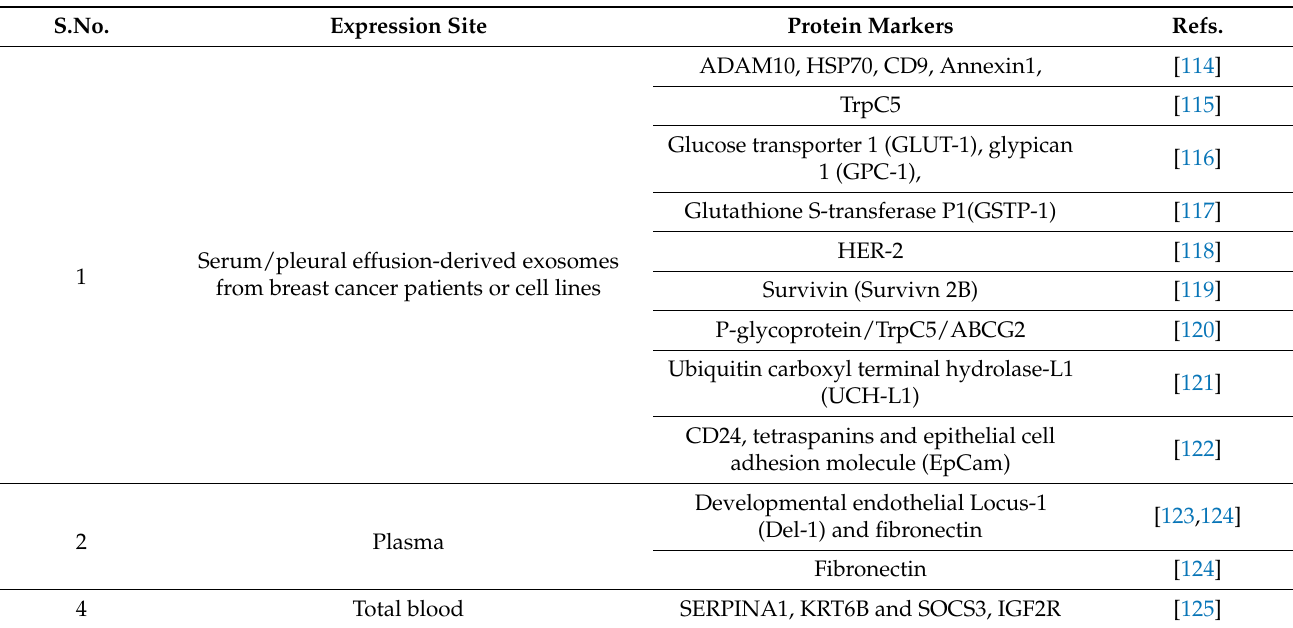
Table 2. List of exosomal protein markers involved in breast